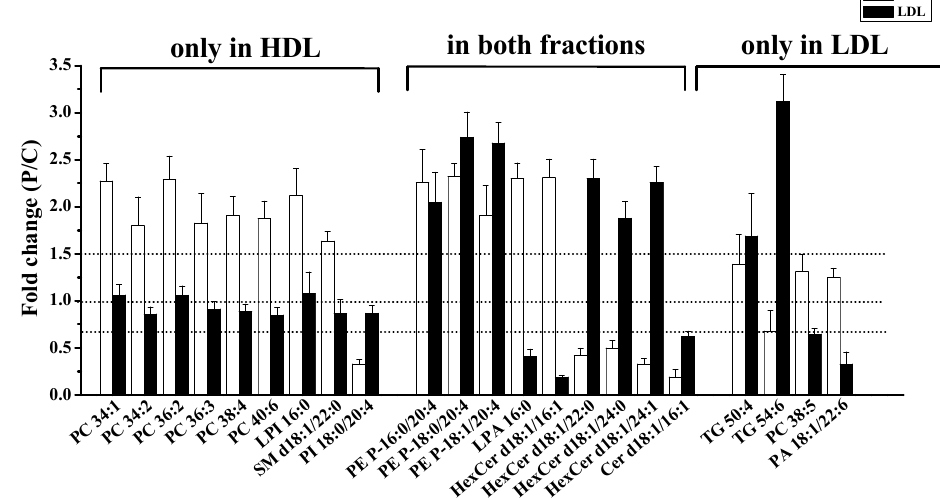
Figure 5. Plot of the fold ratio [PMOp / control (P / C)] of lipid species, showing significant changes ( > 1.5-fold and p < 0.05) in the HDL or LDL fractions, alone or in both fractions. The three PEp species (P-16:0 / 20:4, P-18:0 / 20:4, and P-18:1 / 20:4) in this study increased more than two-fold in both lipoprotein fractions ( p < 0.05). By comparing the relative amounts of these